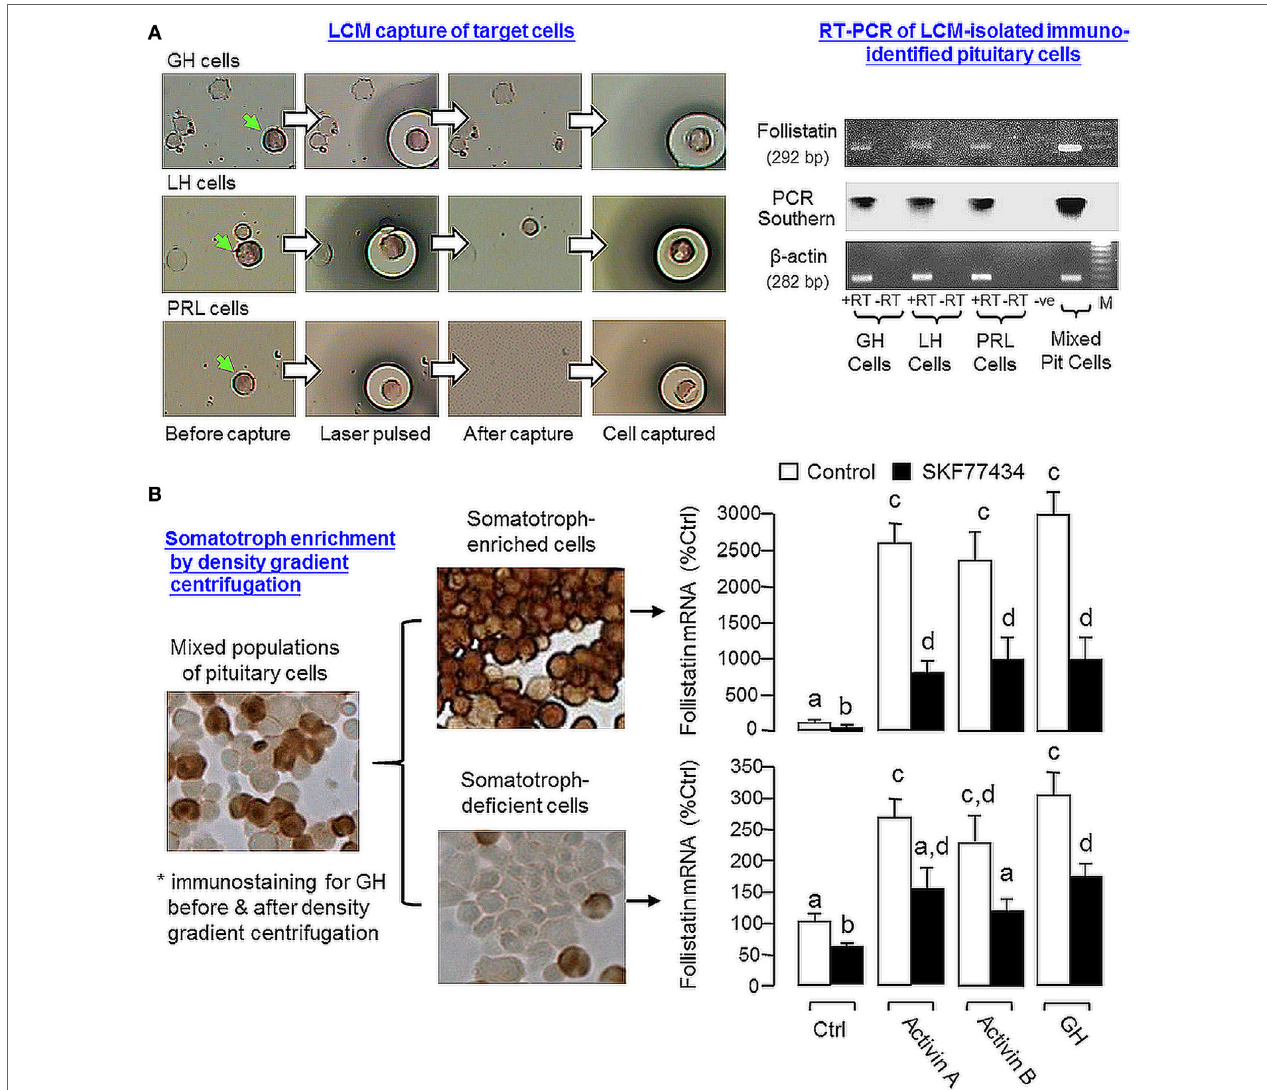
FigUre 7 | Effects of dopamine (DA) D1 activation on follistatin expression induced by activin and growth hormone (GH) in carp somatotrophs. (a) Follistatin expression in carp somatotrophs (GH cells), lactotrophs [prolactin (PRL) cells], and gonadotrophs [luteinizing hormone (LH) cells]. The three cell types (marked by green arrows) were identified by immunostaining using antisera for carp GH, PRL, and LH, respectively, and isolated on HS caps using laser capture microdissection technique. After that, RT-PCR was performed on the cells captured (~200 cells for individual cell types) using primers for follistatin. Mixed populations of pituitary cells were used as a positive control and RNA samples prepared with/without reverse transcription ( ± RT) were used to control for potential contamination with genomic DNA. The authenticity of PCR product was confirmed by PCR Southern using DIG-labeled probe for carp follistatin and parallel PCR for β actin mRNA was used as the internal control. (B) DA D1 activation on activin- and GH-induced follistatin mRNA expression in enriched somatotrophs. Enriched somatotrophs (86–92% pure) were prepared from mixed populations of carp pituitary cells by Percoll gradient centrifugation and the leftover cells (with only 3–4% somatotrophs, referred to as the “somatotroph-deficient” cells) were also harvested to serve as a parallel control. The two cell fractions were treated with activin A (10 ng/ml), activin B (10 ng/ml), and GH (30 ng/ml) for 24 h in the presence or absence of the D1 agonist SKF77434 (1 µM). After that, total RNA was isolated and used for real-time PCR for follistatin mRNA measurement. Data presented are pooled from four experiments ( N = 4) and the groups denoted by different letters represent a significant different at P <